Question: What visual encoding does this figure use to show its data?
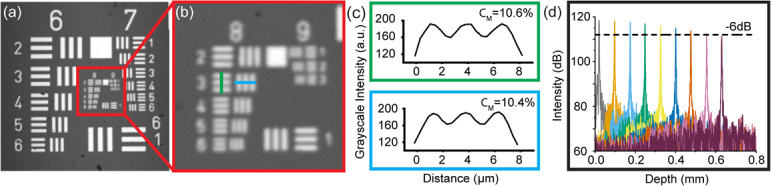
Answer: bar